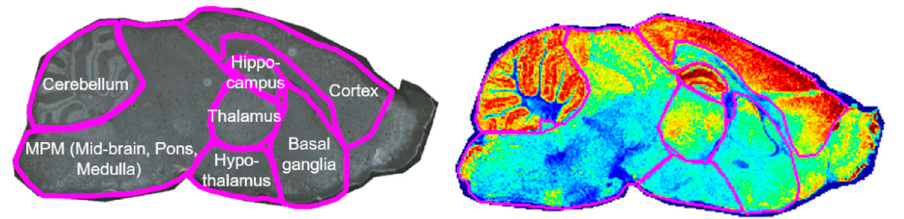
Figure 2. Mouse brain compartmentalization used in this study. The sagittal plane of the mouse brain was divided into seven regions: cerebellum; hippocampus; cortex; thalamus; hypothalamus; midbrain, pons, and medulla; and basal ganglia (left image). The right image represents a whole-brain section mass spectrometry image of [PE(16:0/22:6) − H] − divided into seven regions.